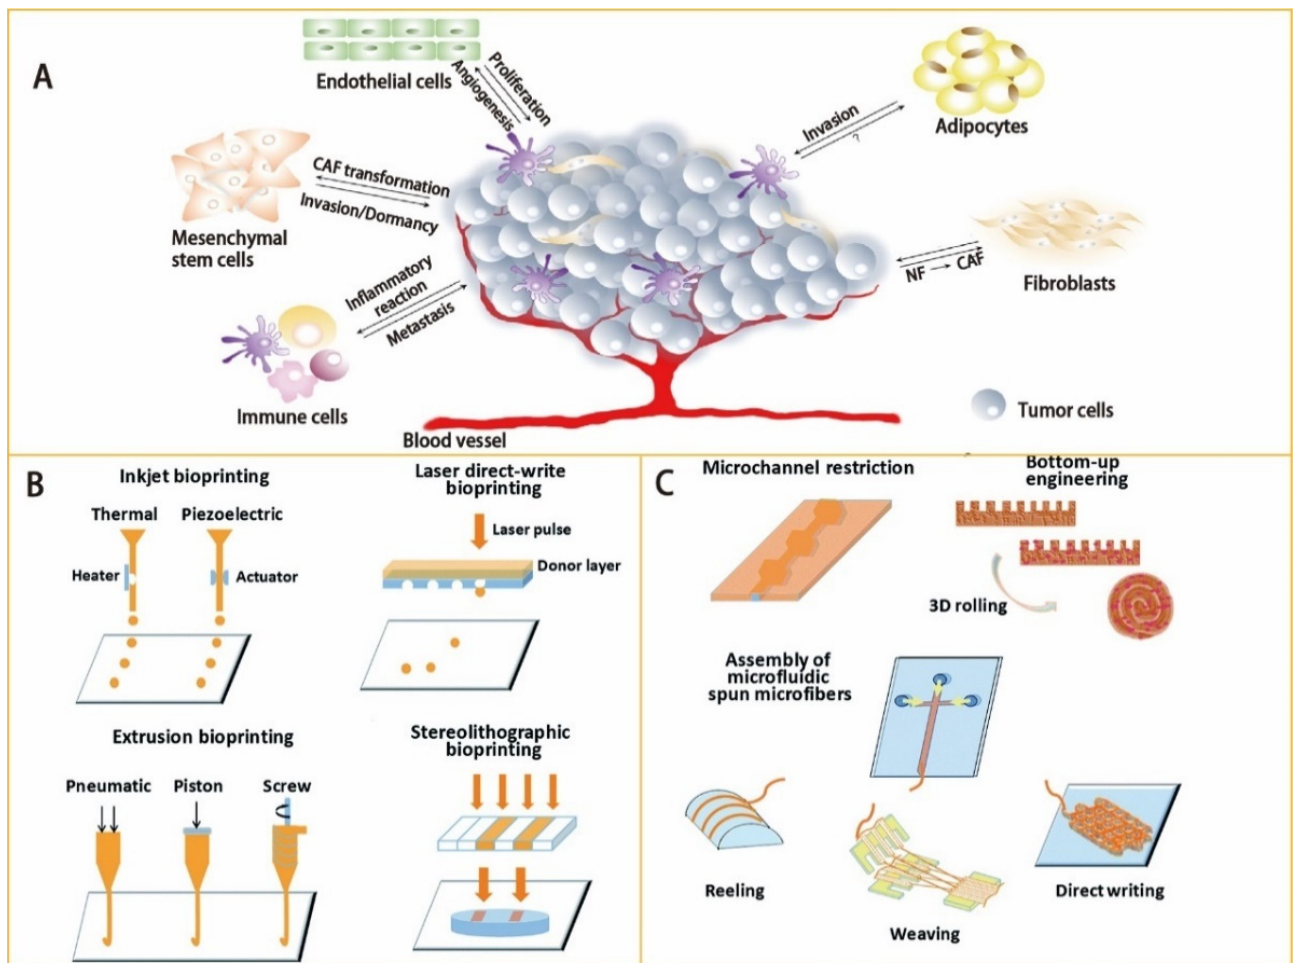
Figure 2. ( A ) The TME is a complex ecosystem consisting of various cellular and noncellular com- ponents, such as cancer cells, fibroblasts, multiple chemical factors, the extracellular matrix, the vasculature system, and mechanical cues. The progression of a tumor is critically influenced by the interaction between tumor and TME. These factors should be included in the construction of OoC models. Adapted with permission from Ref. [56]. Copyright 2019, MDPI. ( B ) Bioprinting techniques mostly used for the generation of microfluidics. Adapted with permission from Ref. [71]. Copyright 2018, Royal Society of Chemistry. ( C ) Microfluidic approaches involved in creating tissues/organs. Adapted with permission from Ref. [71]. Copyright 2018, Royal Society of Chemistry.